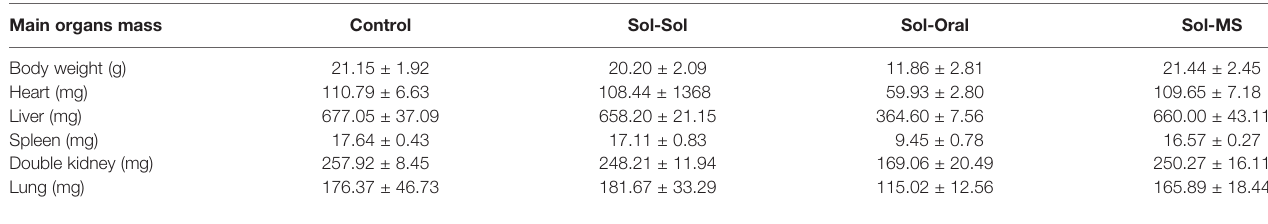
TABLE 3 | The effect of sorafenib formulations on nude mice ’ s body weight and main organs